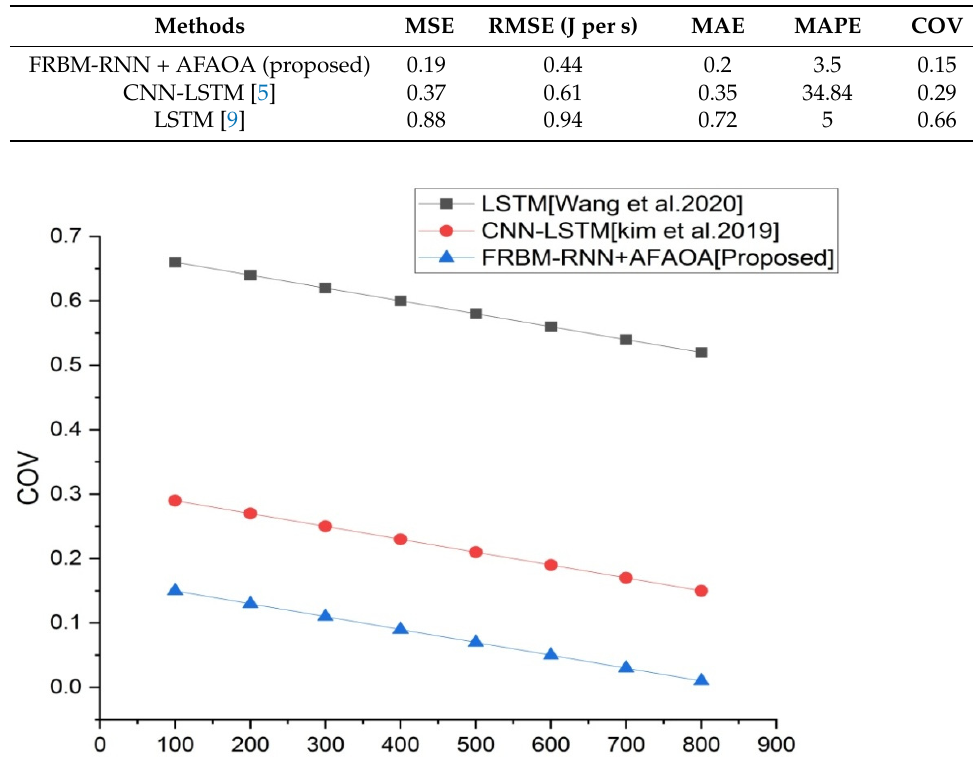
Table 1. Comparative analysis of prediction performance.